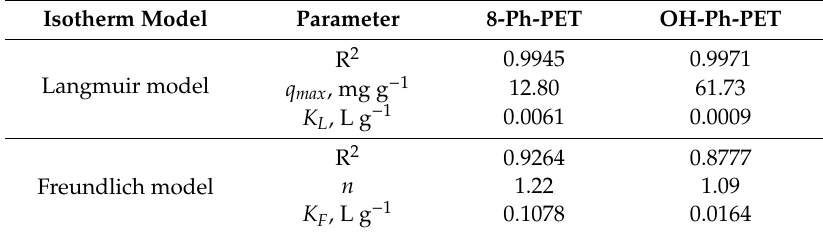
Figure 5. Linear representations of Langmuir ( a ) and Freundlich ( b ) isotherm models for studied adsorption processes. Table 1. Isotherm parameters calculated for the adsorption of Cu(II) ions on 8-Ph-PET and 2-OH-Ph-PET adsorbents.